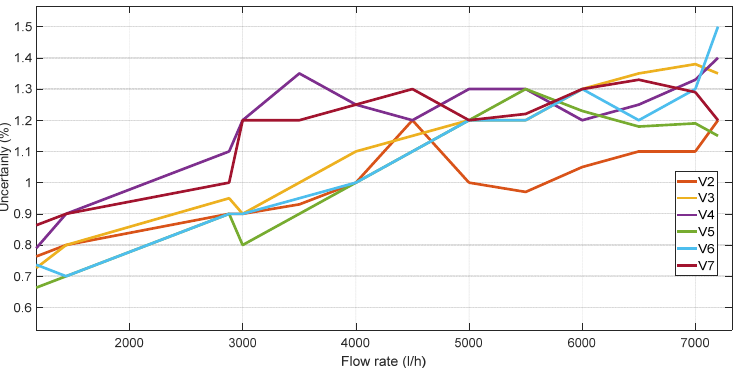
Figure 9. Uncertainty of different mechanical V-designs at high flow rates.